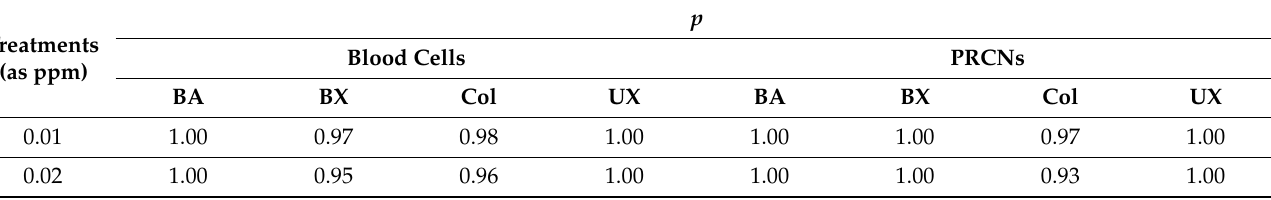
Table 1. The cytotoxicity of boron compounds and aluminum in comparison to untreated cultures.